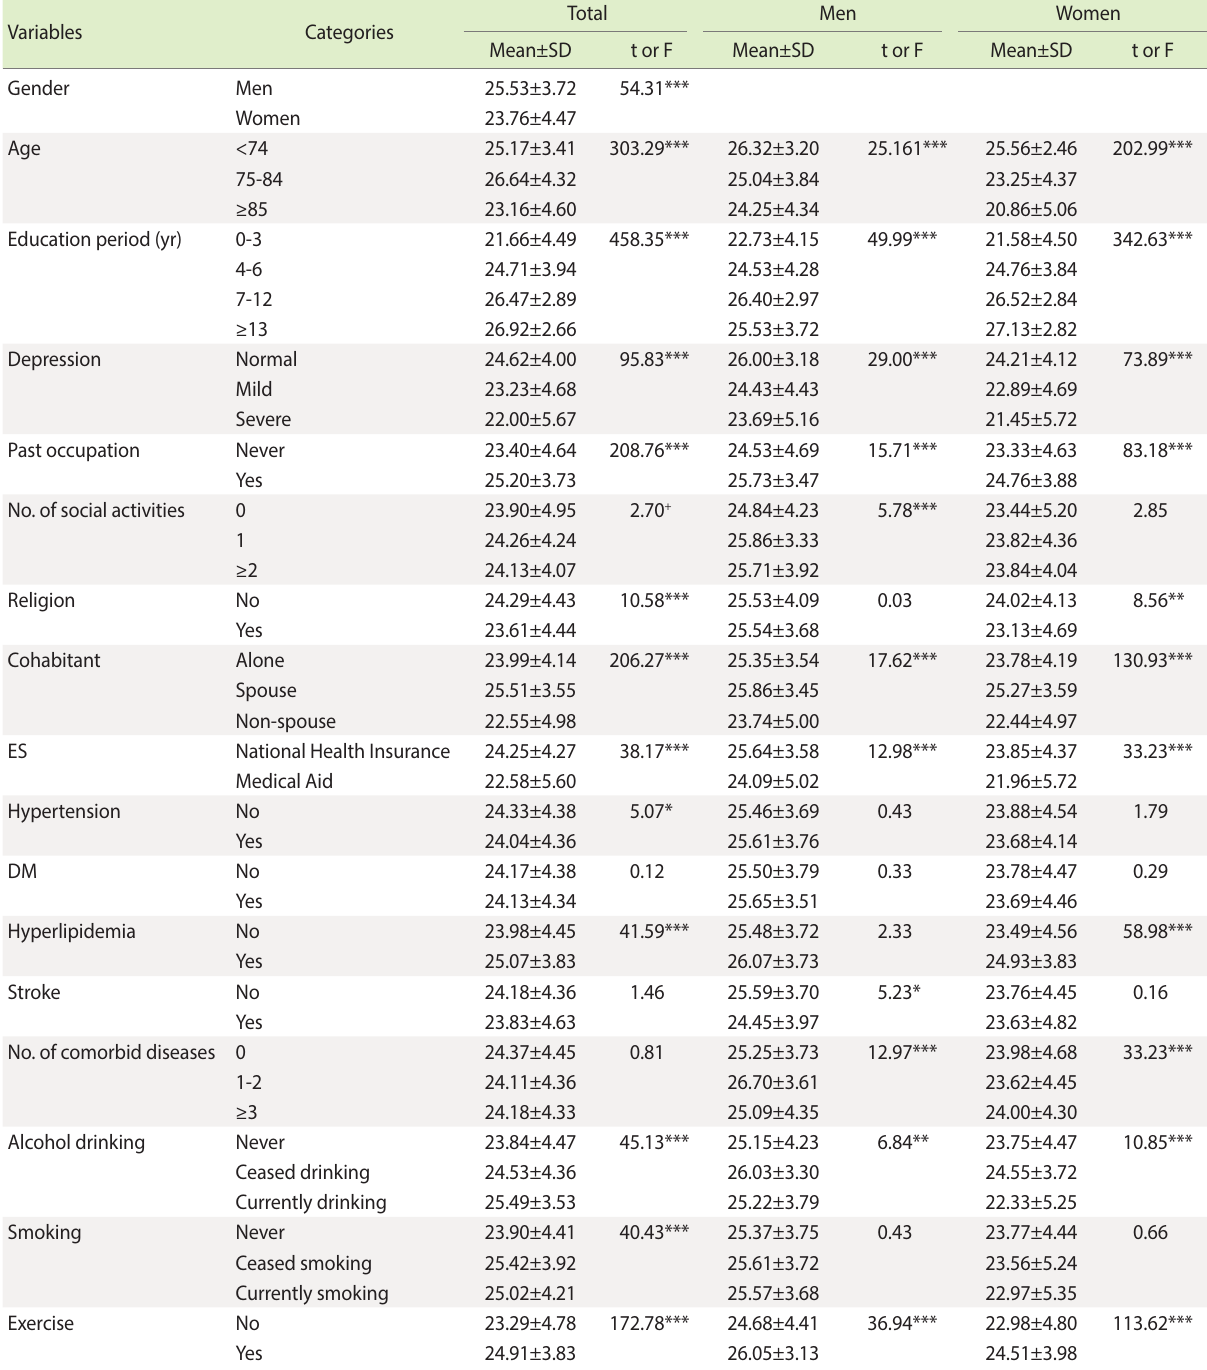
Table 2. Gender comparison of cognitive function score differences by